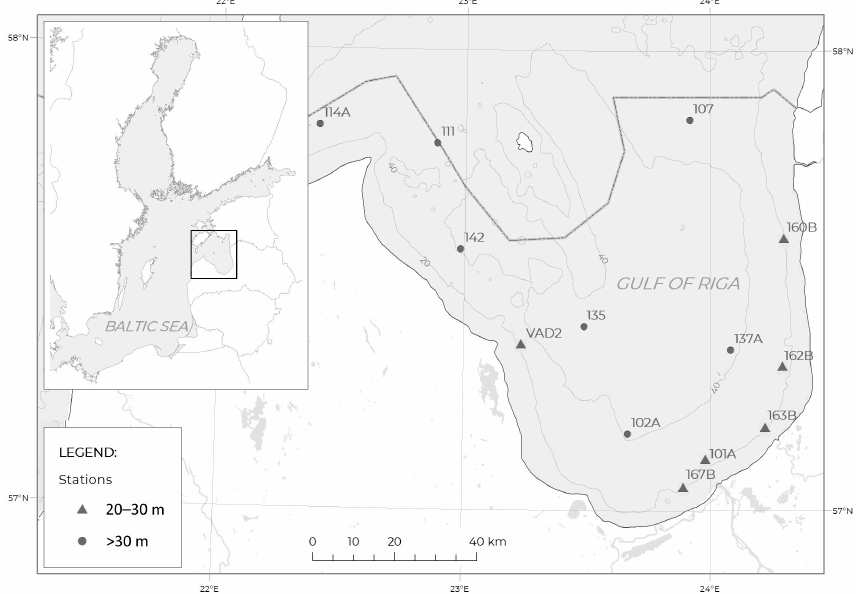
Figure 1. Map of the study area in the Gulf of Riga with markings of coastal (20–30 m) and deep-water (>30 m) stations.